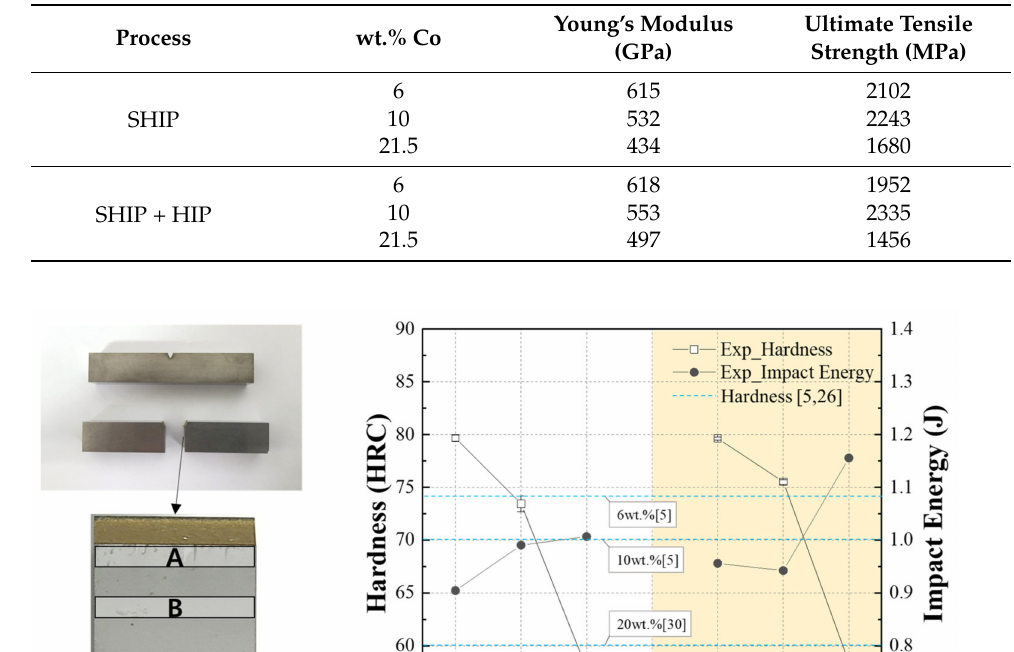
Table 3. Material properties of WC-Co according to the Co content.